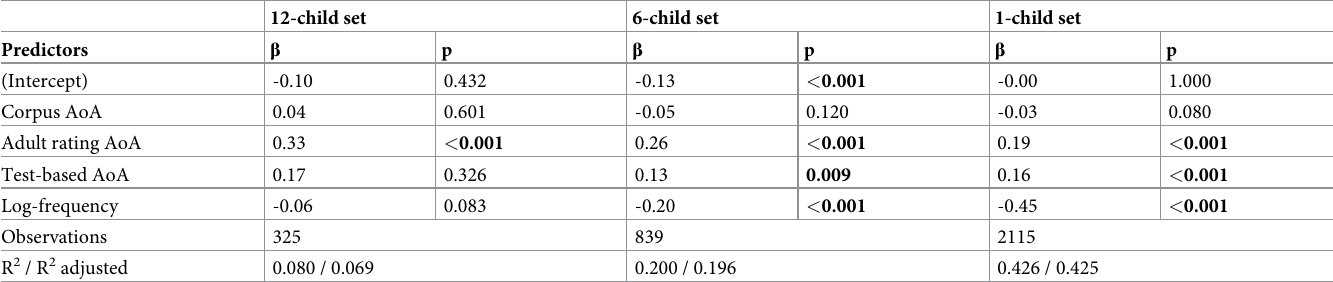
Table 3. Standardized coefficients from regression analyses examining the effects of AoA predictors on lexical decision